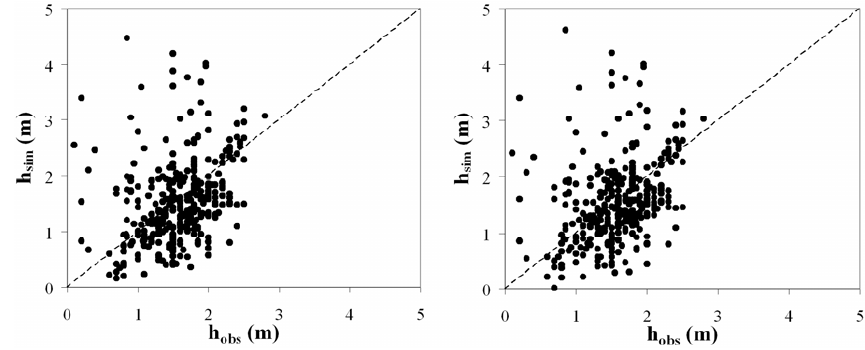
Fig. 8. Dotty plots related to the calibrations with 343 data points and calibration strategies C (left) and F (right).